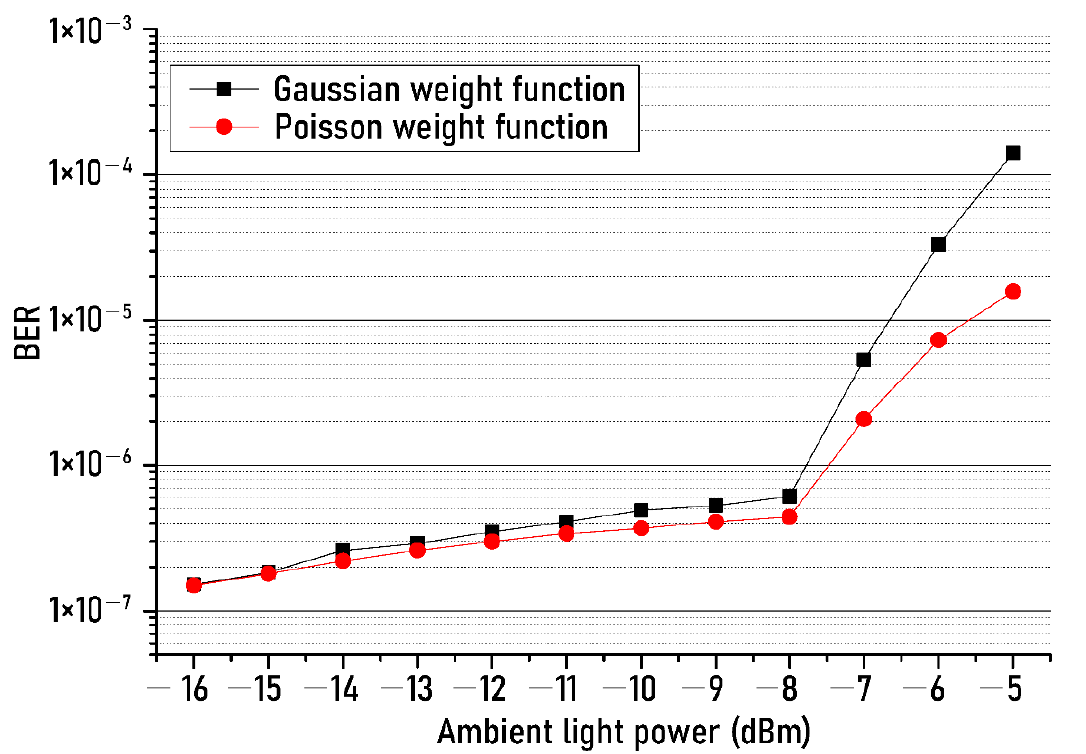
Figure 6. BER changes of recovered NRZ − OOK signal against two different weight functions.